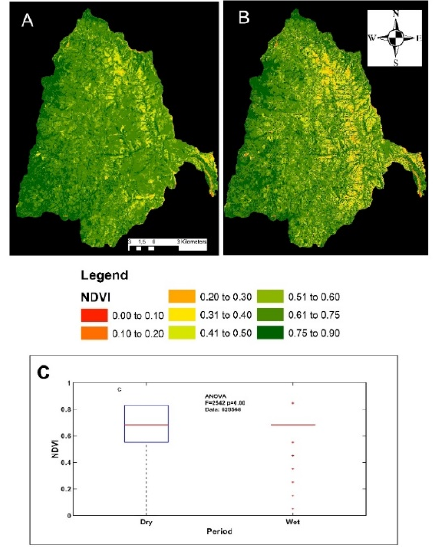
Figure 5. Changes in the NDVI values between wet ( A ) and dry ( B ) periods, for the year 1997 and comparison of these for the same periods ( C ).